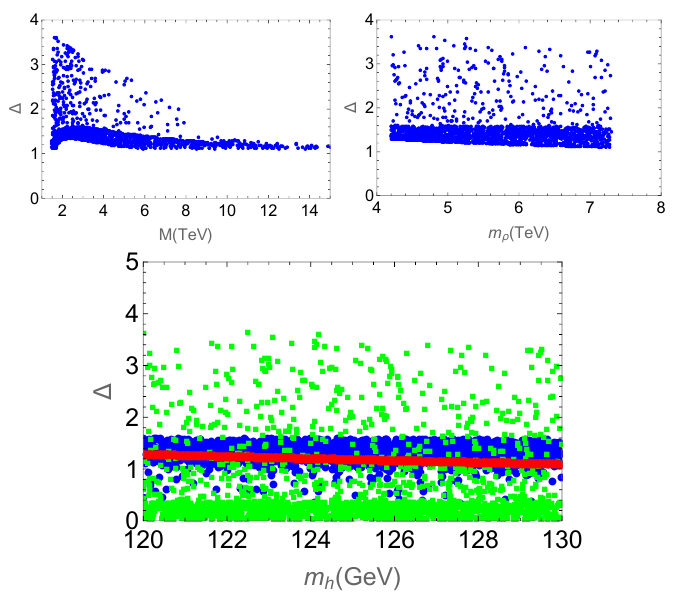
Figure 2 . Scatter plot in N-suppression twin Higgs model SO(8) = SO(7) for (cid:24) = 0 : 01. The range of the parameters is taken as follows: m t [140 ; 170] GeV, M > 1 : 5 TeV and m (cid:26) > 2 : 5 TeV. 2 Top: in left panel (cid:12)ne tuning (cid:1) as a function of M and in right panel as a function of m (cid:26) for m h [120 ; 130] GeV. Bottom: scatter plot of tuning (cid:1) i for various input parameters x i , M (blue), 2 (cid:15) L (green) and m (cid:26) (red), as a function of m h